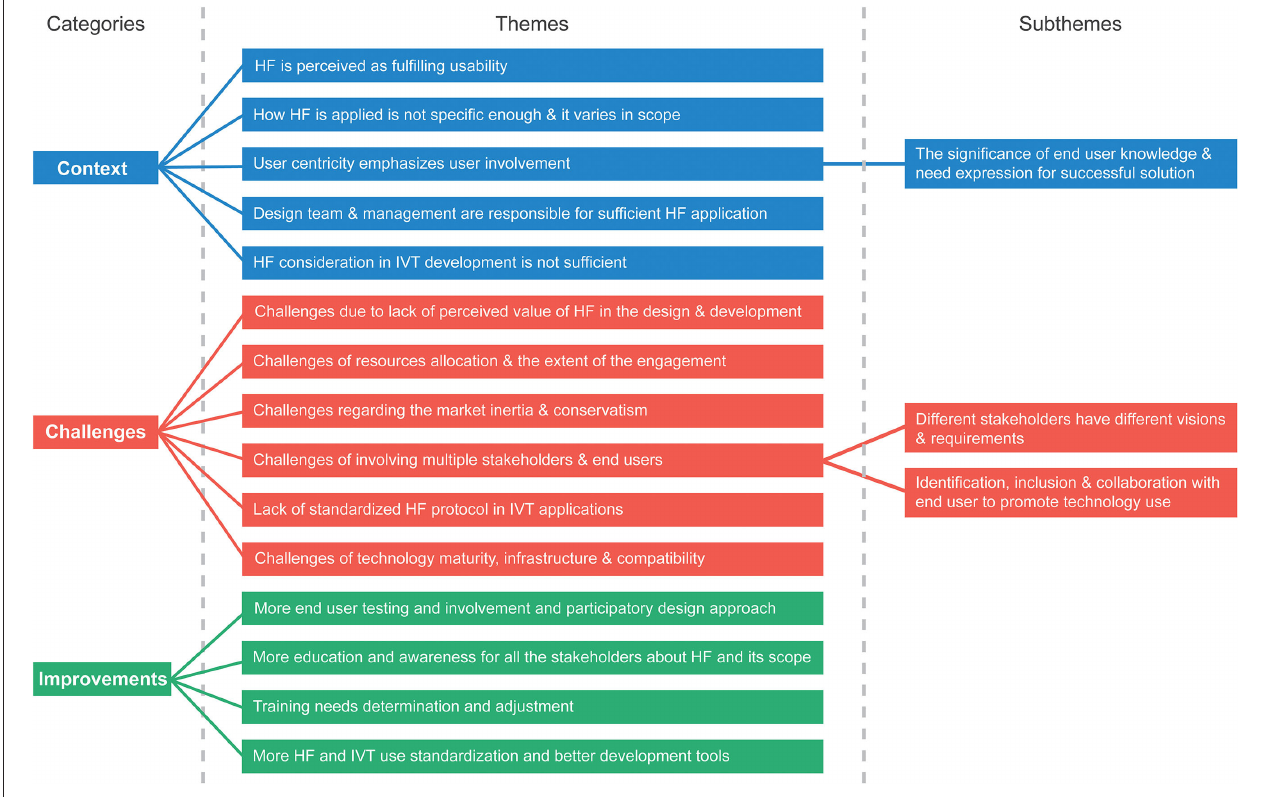
Frontiers in Psychology |